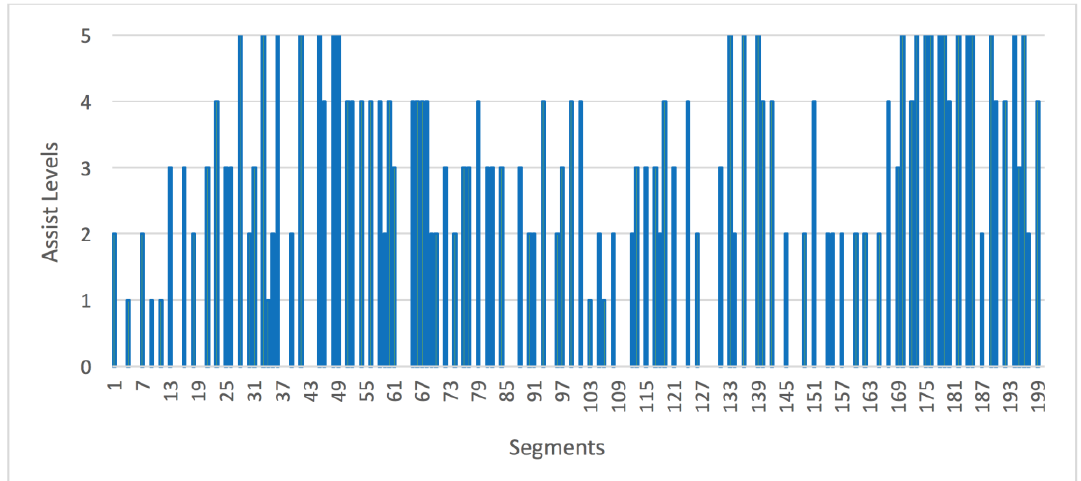
Figure 8. Levels of assistance calculated for each segment.